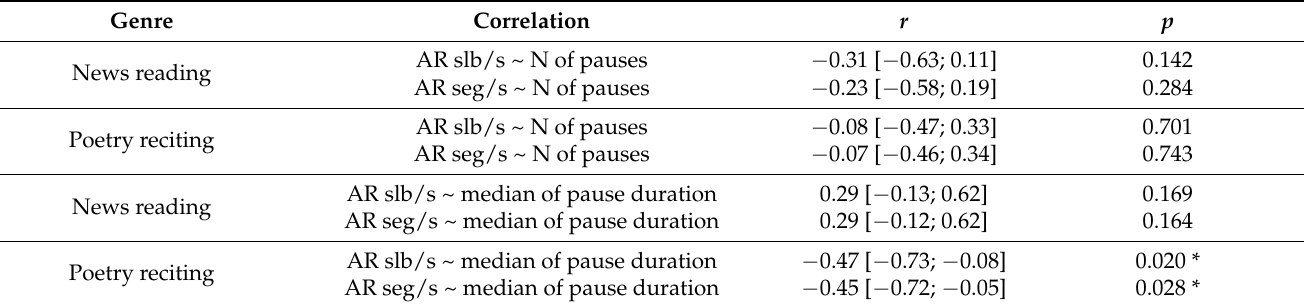
Table 3. Pearson’s correlations between the speaker tempo and the frequency or duration of pauses per speaker in two genres. Coefficients (incl. 95% CIs) and their associated p -values are